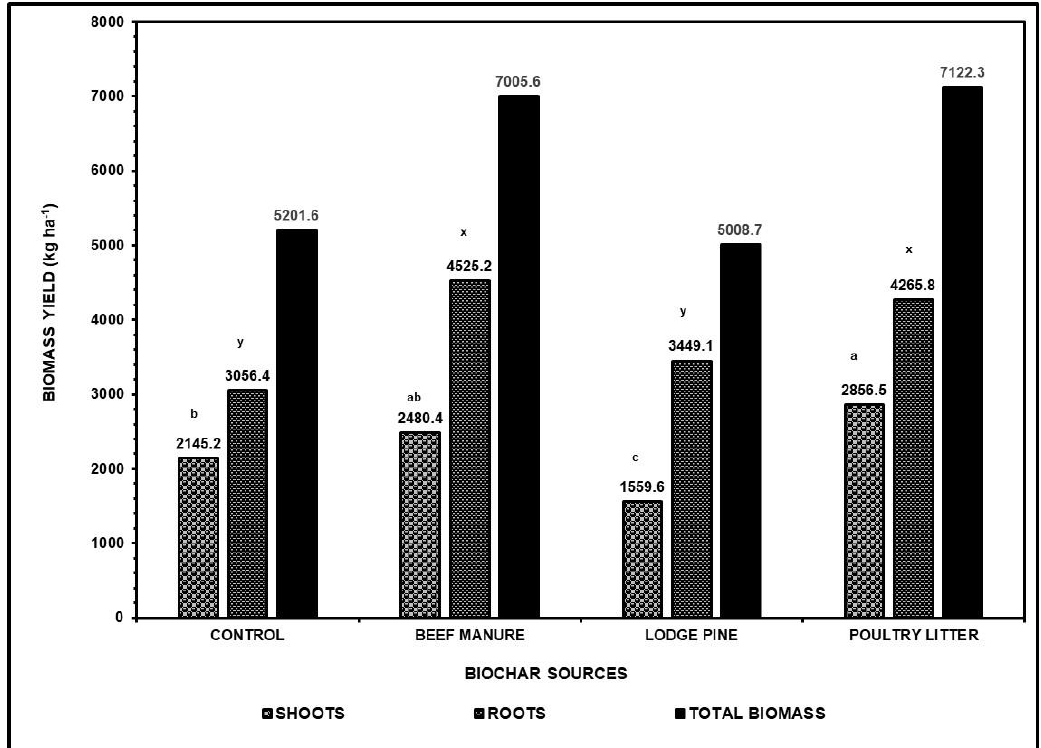
ff erent additions of